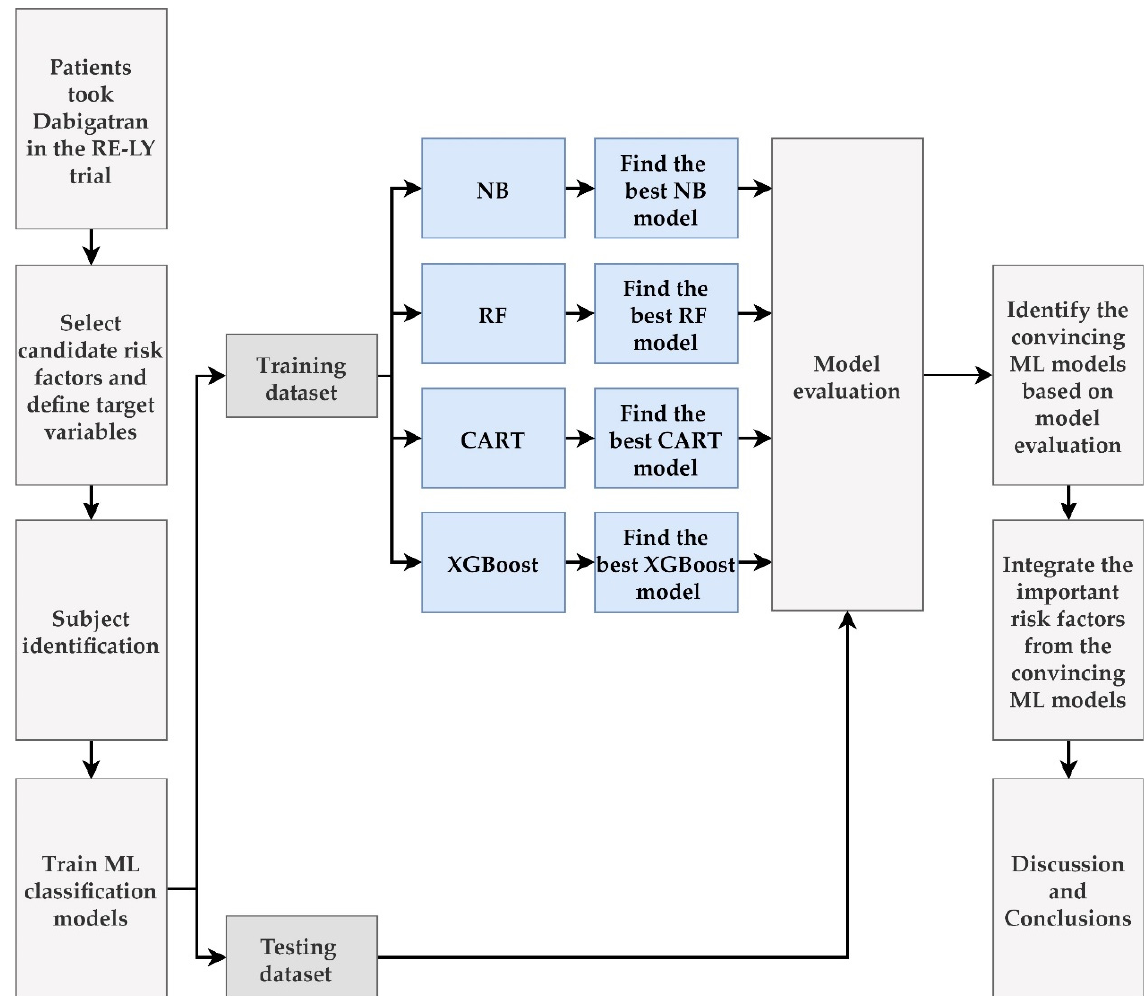
Figure 1. Flow chart of the proposed integrated ML feature selection scheme.